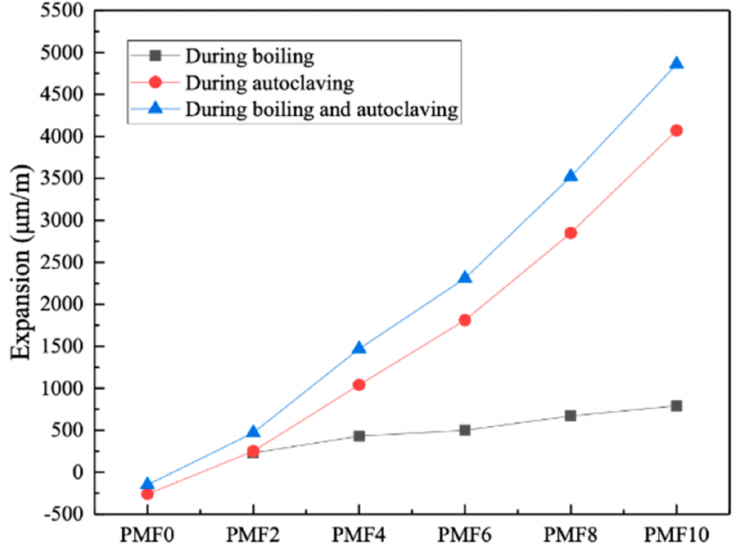
Figure 8. Effect of nano-MgO content on stability of cement